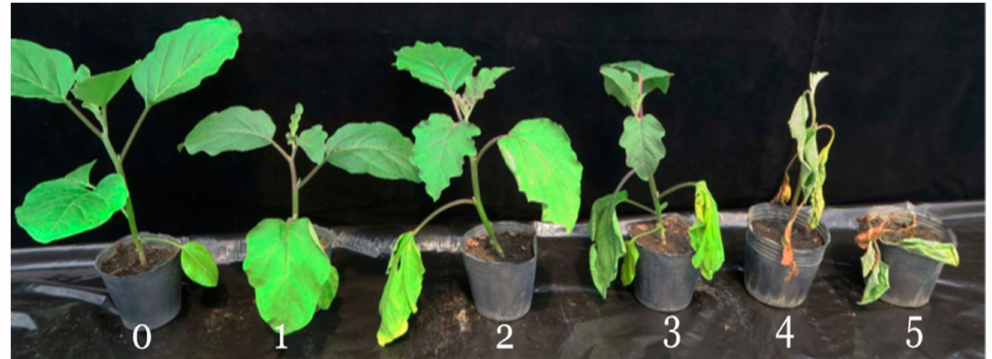
Figure 1. Disease rating scale 0–5 according to [35], where 0 = no symptoms, 1 = only one leaf partially wilted, 2 = two or three leaves wilted, 3 = all leaves except two or three wilted, 4 = all leaves wilted, and 5 = plant dead.